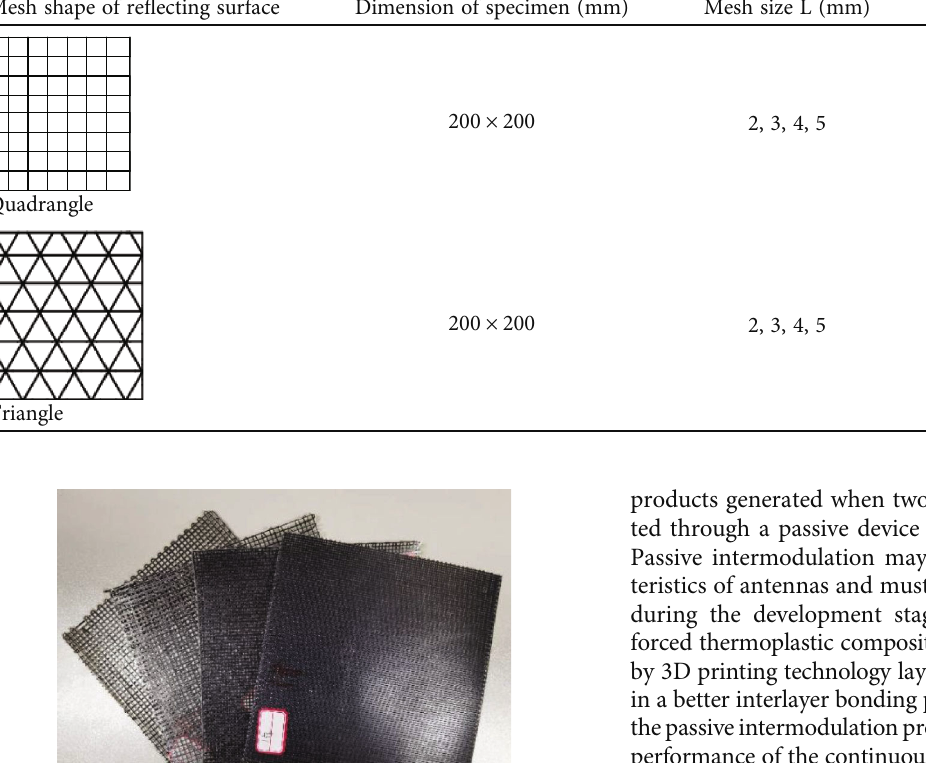
Table 1: The continuous fi ber reinforced thermoplastic composites re fl ecting surface with di ff erent mesh shape and mesh size. Mesh shape of re fl ecting surface